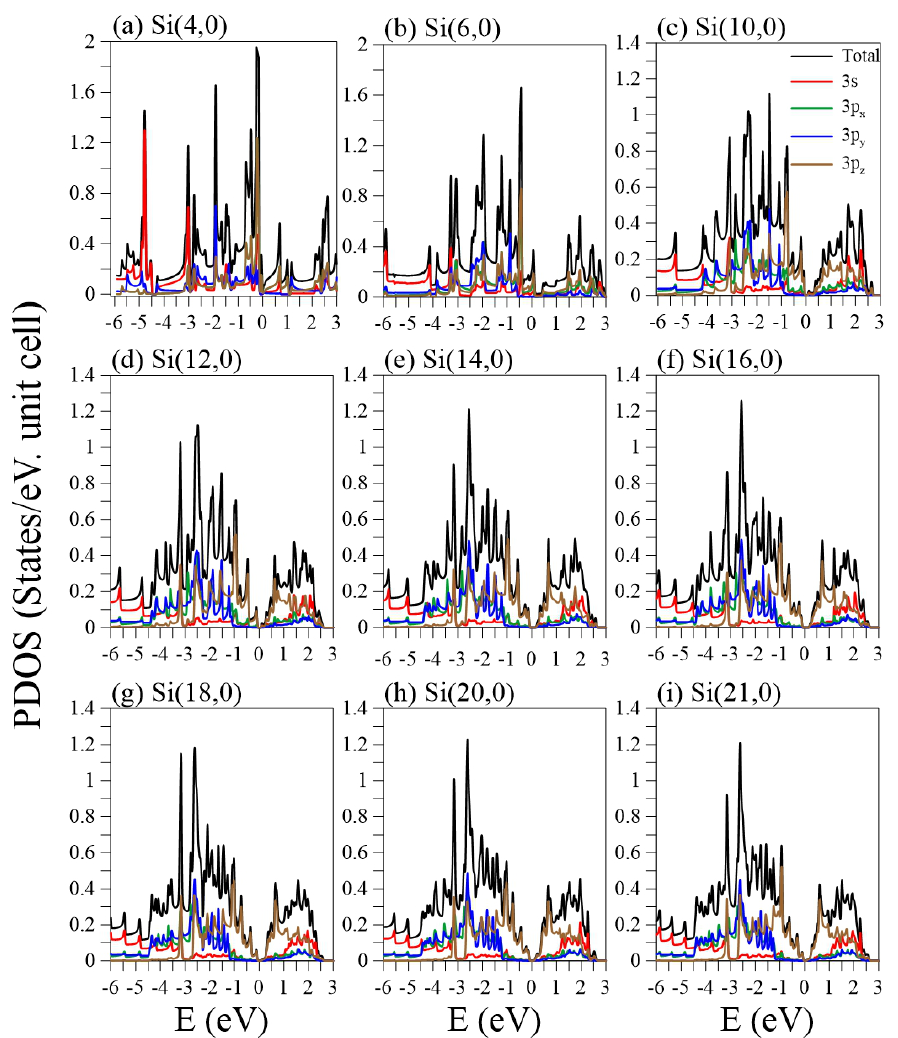
Figure 8. The orbital-projected densities of states for zSiNTs with different chiral vectors: ( a ) (4,0), ( b ) (6,0), ( c ) (10,0), ( d ) (12,0), ( e ) (14,0), ( f ) (16,0), ( g ) (18,0), ( h ) (20,0), and ( i )